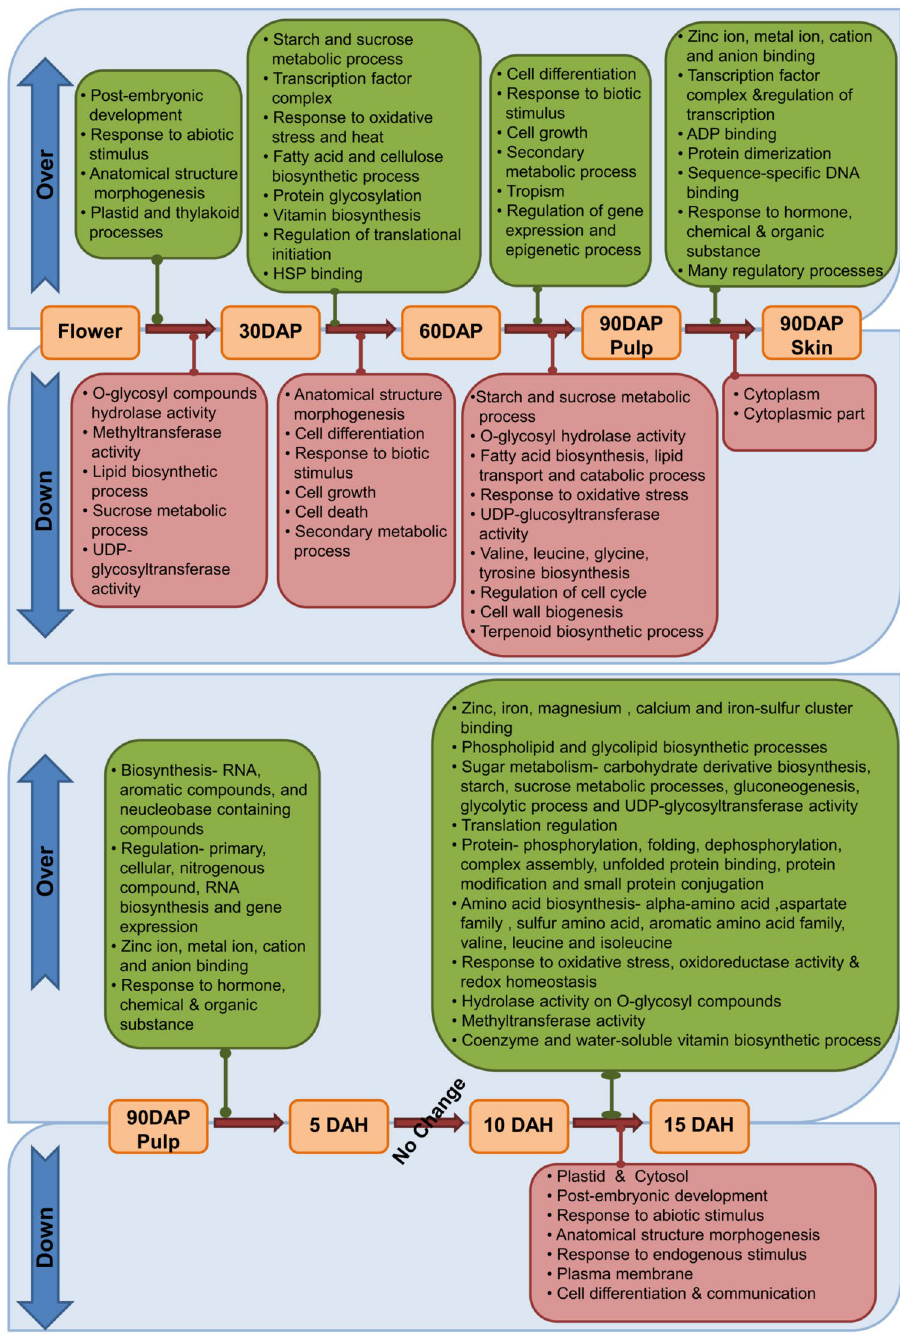
biosynthetic processes; methyltransferase, UDP-glycosyltransferase and O- glycosyl hydrolase activities; starch, sucrose metabolic processes, gluconeogenesis and glycolytic process; protein phosphorylation, dephosphoryl- ation, folding, protein modification and small protein conjugation along with the regulation and response to oxidative stress, oxidoreductase activity and redox homeostasis. While the GOs related to plastid and cytosol; post embryonic development; response to abiotic and endogenous stimulus; anatomical structure morphogenesis, plasma membrane, cell differentiation and communication were down-represented. Spatial changes in transcriptome at 90